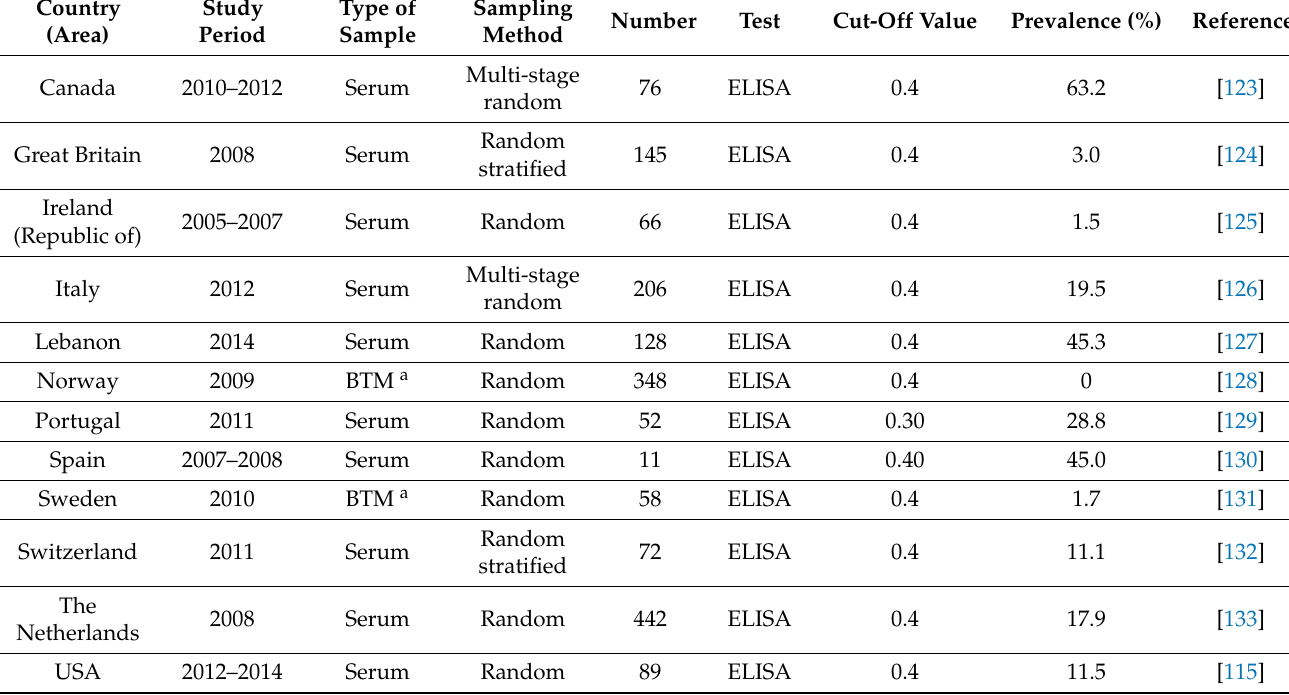
Table 3. Prevalence of antibodies anti- C. burnetii at goat herd level.